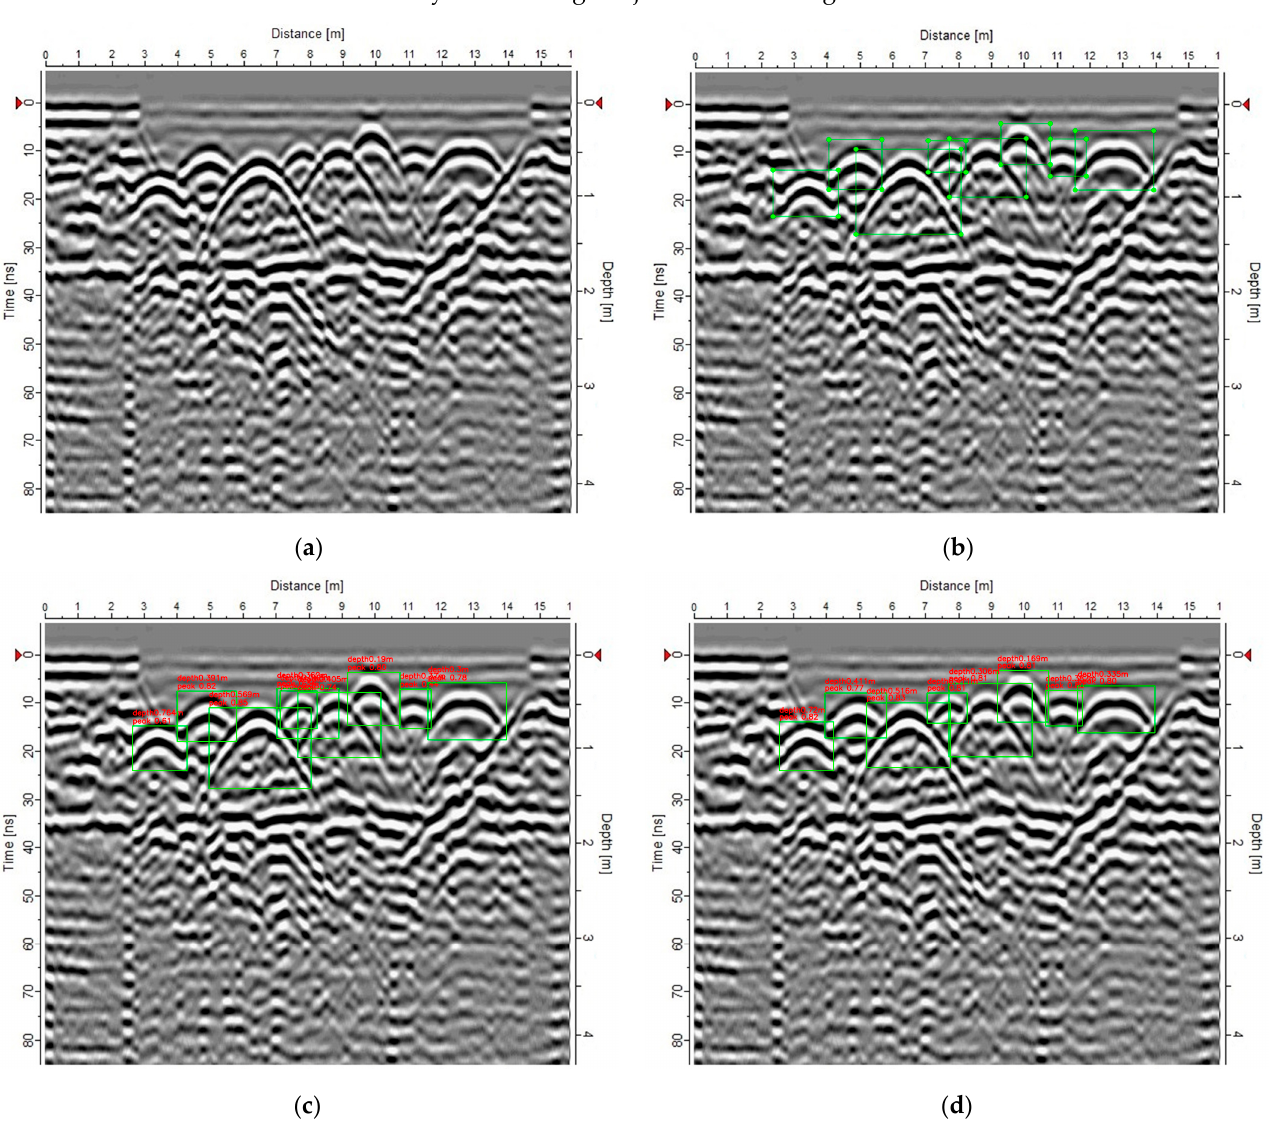
Figure 24. ( a ) Original image; ( b ) foreign objects expected to be detected; ( c ) foreign objects detected by the YOLOv5 algorithm; ( d ) foreign objects detected by the improved YOLOv5 algorithm.